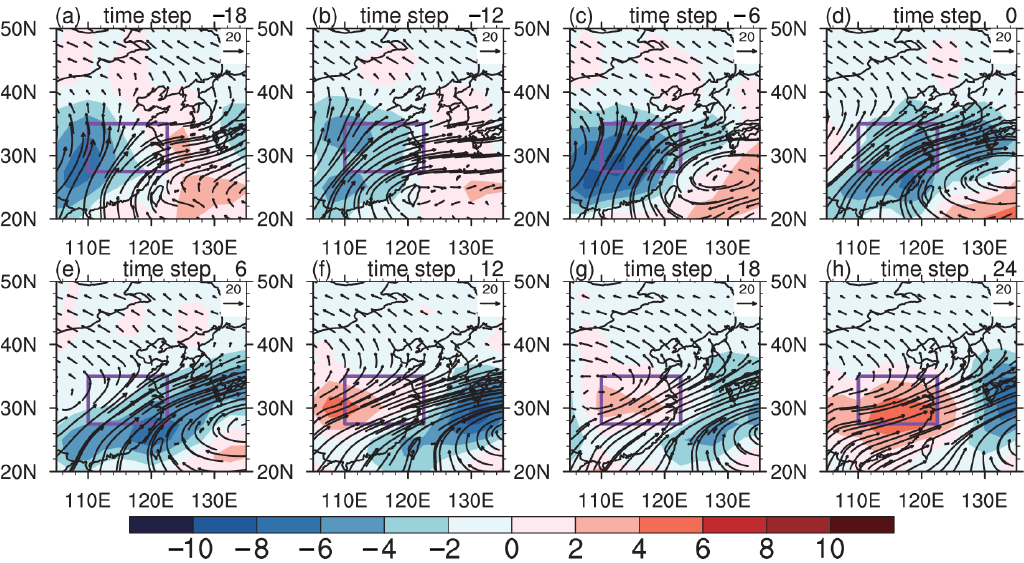
Figure 5. Evolution of vertically integrated WVT anomalies (vectors, kg/(m·s) with respect to winter climatology and the associated divergence (colors, 10 –5 kg/(m 2 ·s)) at time steps (a) –18, (b) –12, (c) –6, (d) 0, (e) 6, (f) 12, (g) 18, and (h) 24 for ISEs in the YRV region.